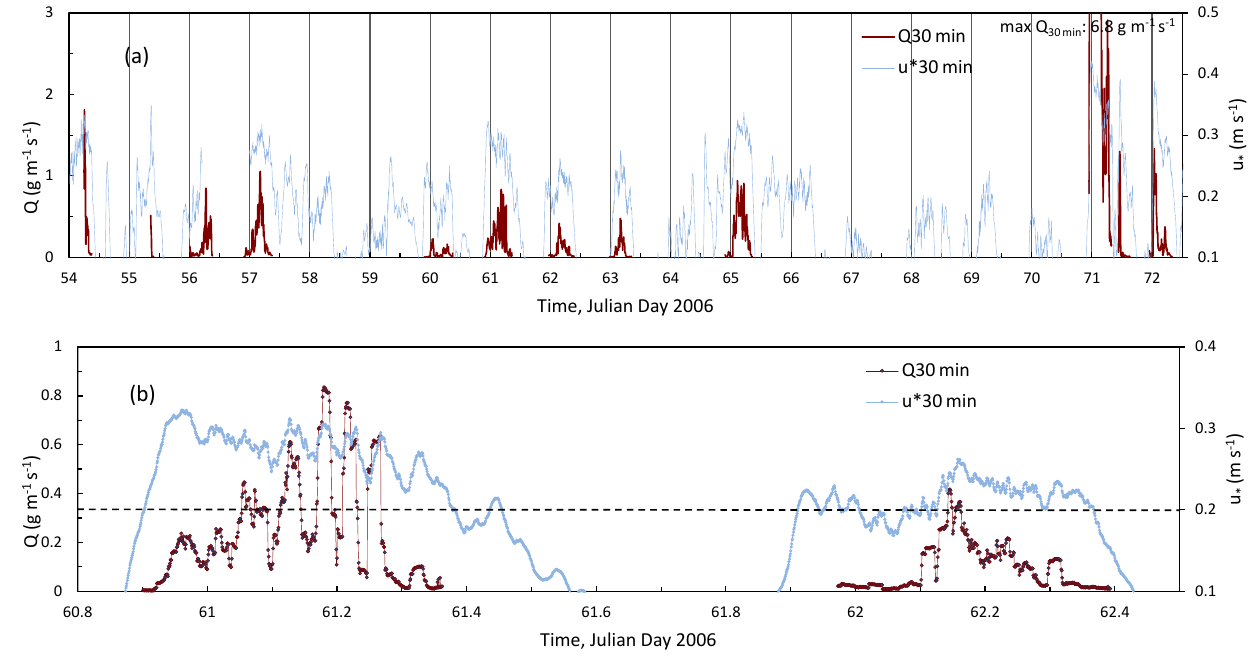
Figure 2. As Fig. 1 but for running means over 30min